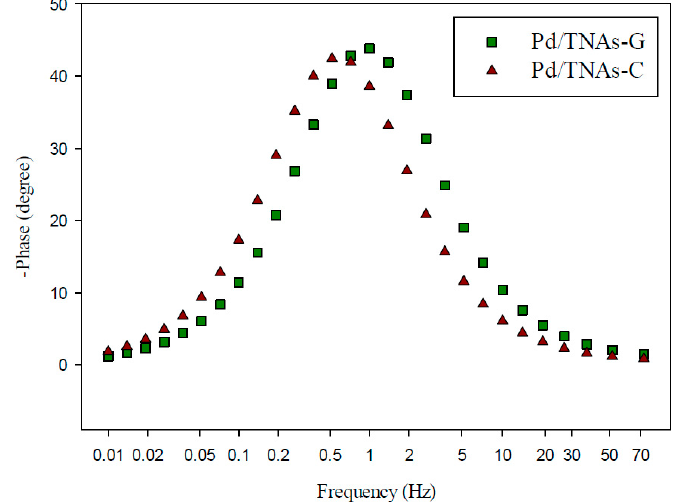
/ TNAs-C and Pd / TNAs-G under 100 W Hg Figure 7. Bode plot of Pd/TNAs-C and Pd/TNAs-G under 100 W Hg lamp. Figure 7. Bode plot of Pd Figure 7. Bode plot of Pd/TNAs-C and Pd/TNAs-G under 100 W Hg lamp.